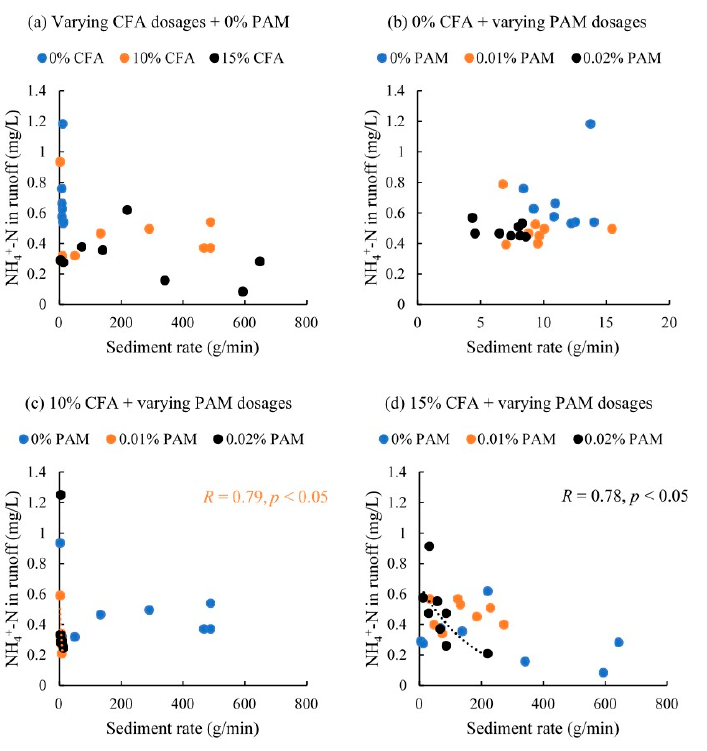
Figure 7. Correlation between NH 4+ -N concentrations in runoff and sediment rate for varying CFA dosages + 0% PAM ( a ), 0% CFA + varying PAM dosages ( b ), 10% CFA + varying PAM dosages ( c ), 15% CFA + varying PAM dosages ( d ). 15% CFA + varying PAM dosages ( d ).